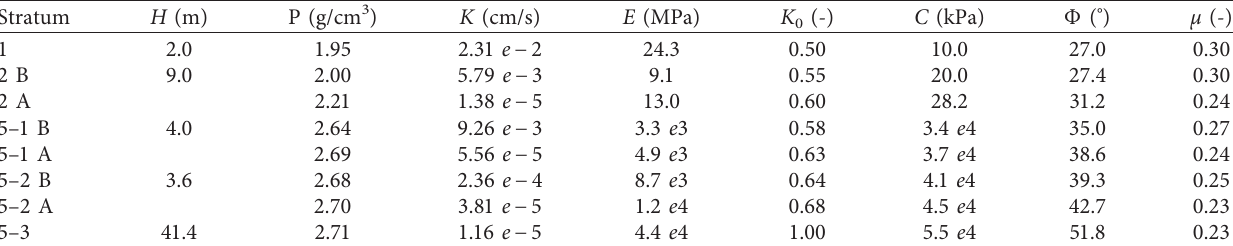
Figure 6: FE model of double-arch Table 1: Soil parameters.